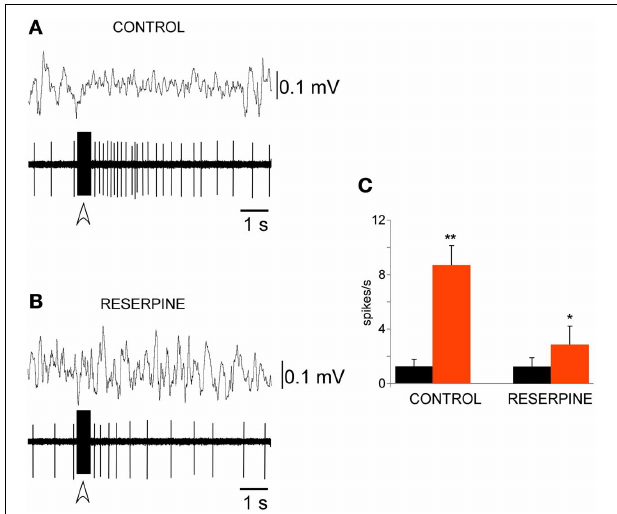
FIGURE 6 | PnO electrical stimulation evoked a long-lasting inhibition of PeFLH neurons. (A) Electrical train stimulation of the PnO nucleus evoked a decrease in PeFLH neuronal activity for 5s accompanied by a slight decrease in EEG slow waves. The stimulation train is indicated with open arrow. (B) The PnO-evoked inhibition was abolished by bicuculline (10mM). (C) Plot of the mean firing rate calculated for the 10s period before (black) and after (red) the PnO stimulation train in control animals ( n = 14 cells) and 5min after bicuculline application ( n = 8 cells). The PnO-evoked inhibition was blocked by the GABA A receptor antagonist. The asterisk indicates significant statistical differences ( ∗∗ p < 0 .